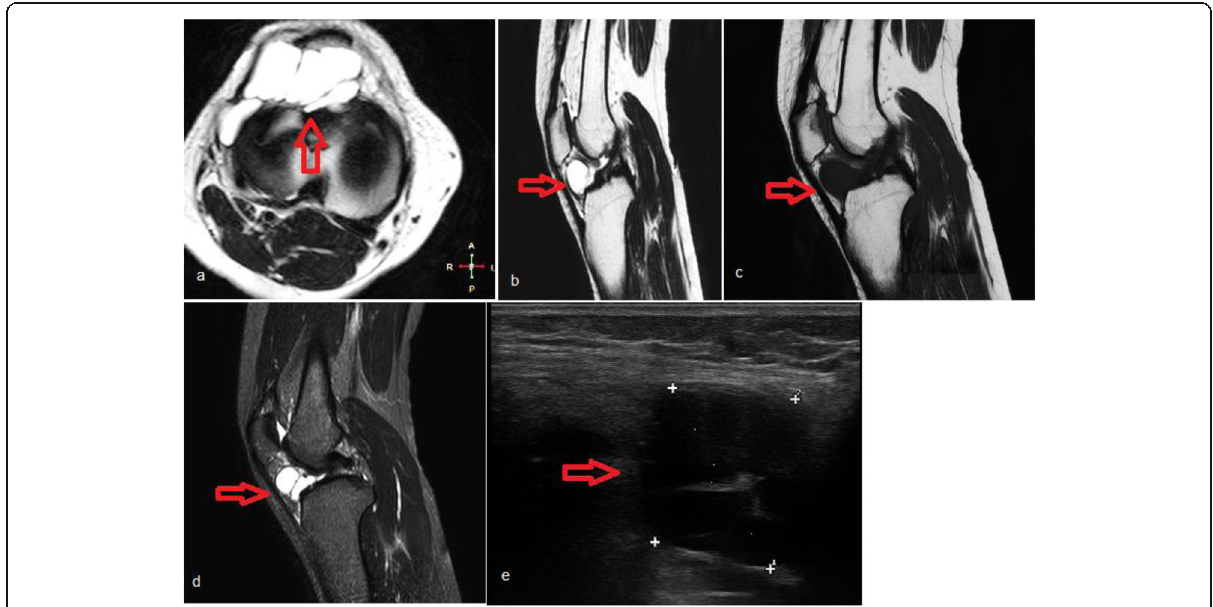
Fig. 10 a – d MRI images and e a high-resolution ultrasound image for Hoffa ’ s pad fat ganglion cyst. a Axial T2WI, b sagittal T2WI, c sagittal T1WI, and d sagittal PD fat suppression demonstrated a large well-defined lobulated intra-articular cystic lesion within the infrapatellar fat pad. It elicited a low signal on T1WI and a bright signal on T2WI and PD fat suppression (red open arrows). e B-mode image demonstrated anechoic lobulated and septated Hoffa ’ s pad fat cyst concordant with the MRI findings